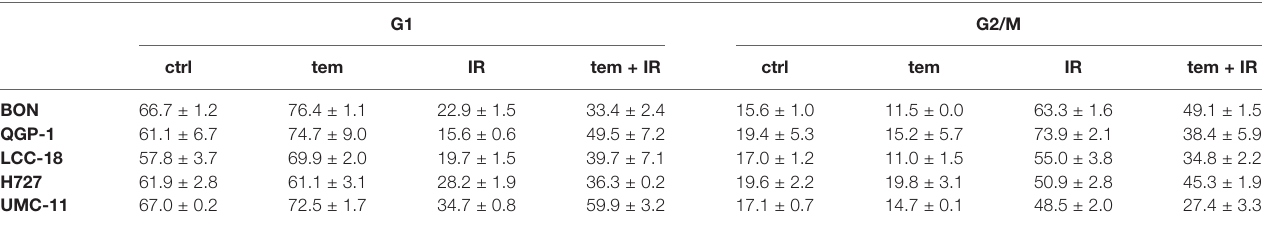
TABLE 4 | Percentages of cells in G1 and G2/M cell cycle 24 h after irradiation. G1 G2/M ctrl tem IR tem + IR ctrl tem IR tem + IR